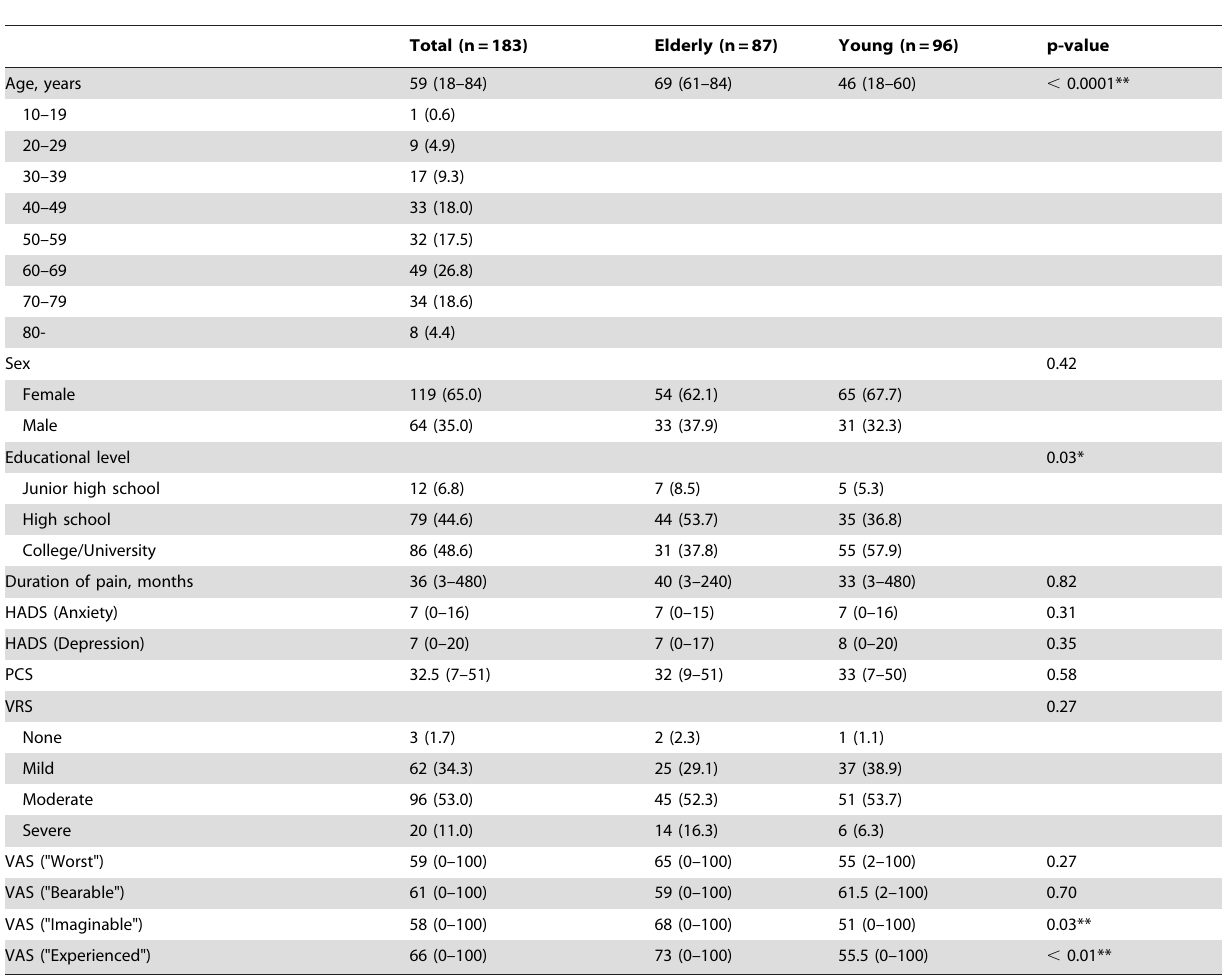
Table 1. General characteristics of study participants